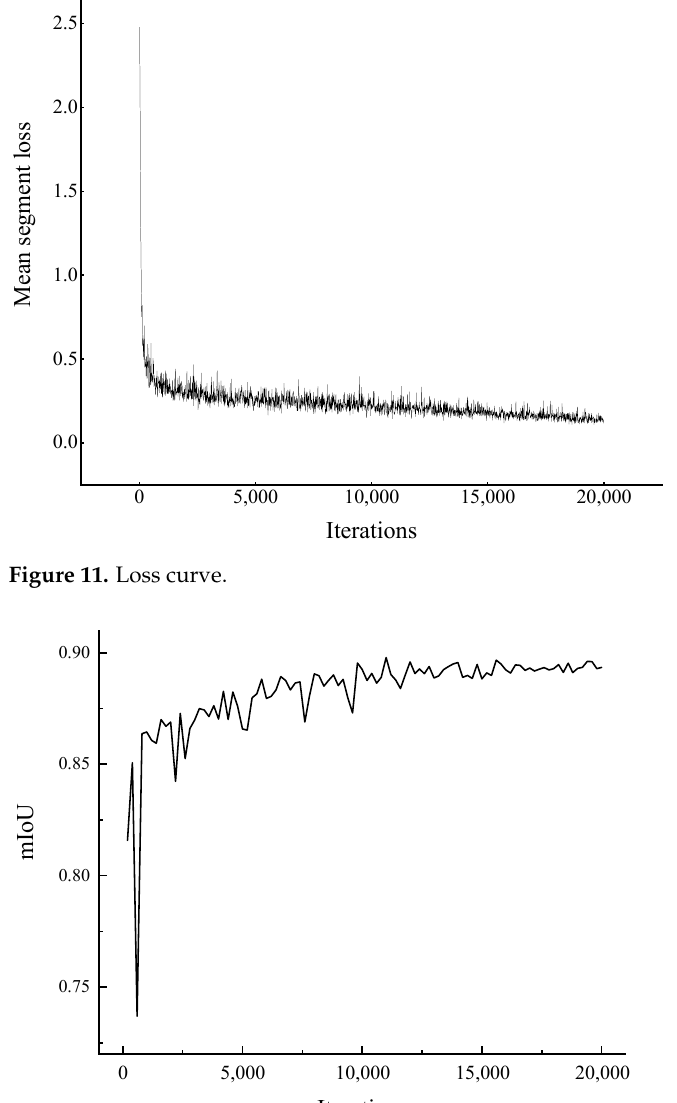
Figure 12. Mean intersection over union curve.